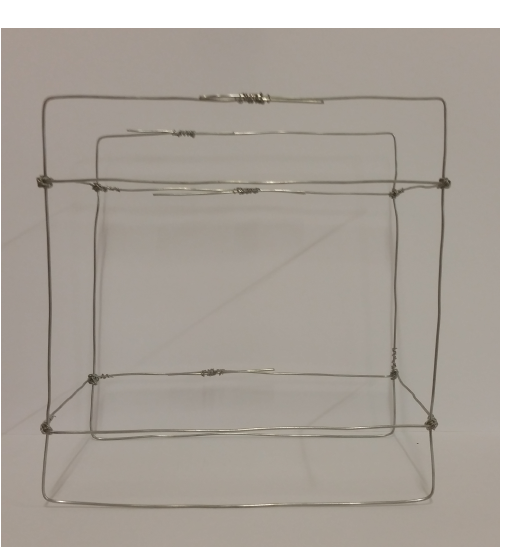
Figure 3. Steel wire frame.